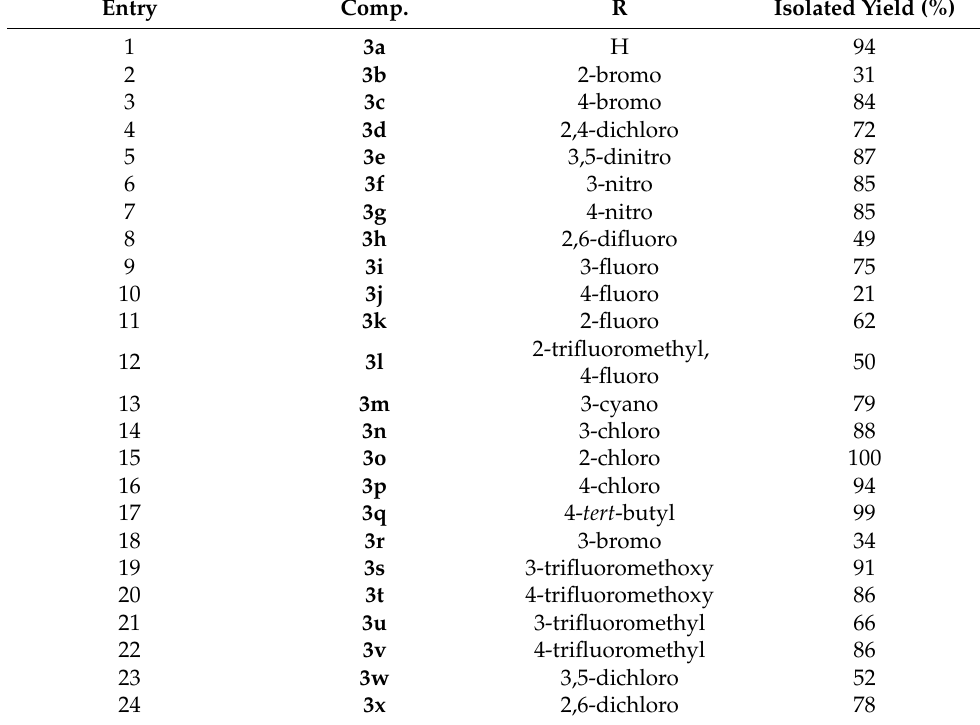
Table 1. Chemical structures and yields of the synthesized melatonin analogues 3a – x